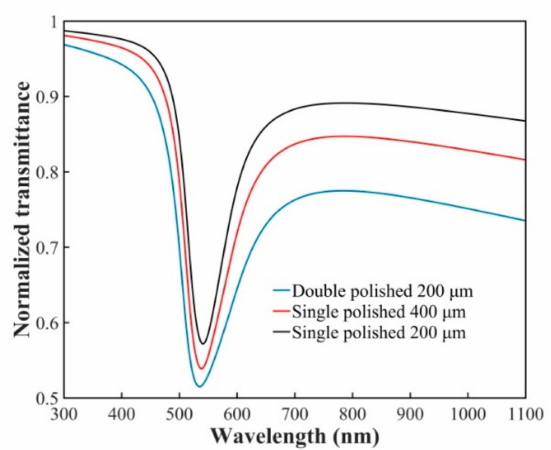
Figure 2. The simulation results of the normalized transmitted spectra for the single and double-sided polished fiber SPR probes with different polished depths in the external medium with refractive index (RI) of 1.34.